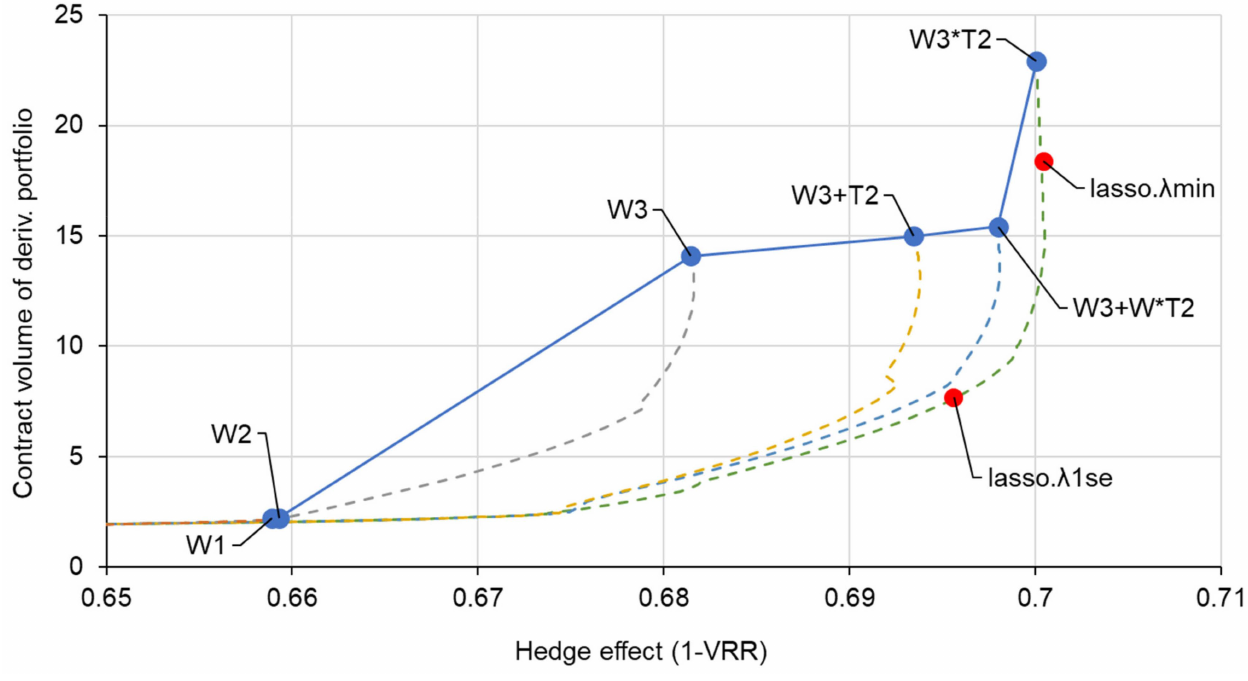
Figure A1. Relationship between contract volume and hedge effect by hedging model (cases in which no mean value correction was made for the underlying indexes). Note: the term “lasso” refers to the W3*T2 model estimated by LASSO regression. Hedge effect is measured in out-of-sample periods. Note: the blue dots represent the estimation results from OLS and the dashed curves represent the estimation results obtained by varying λ in the LASSO